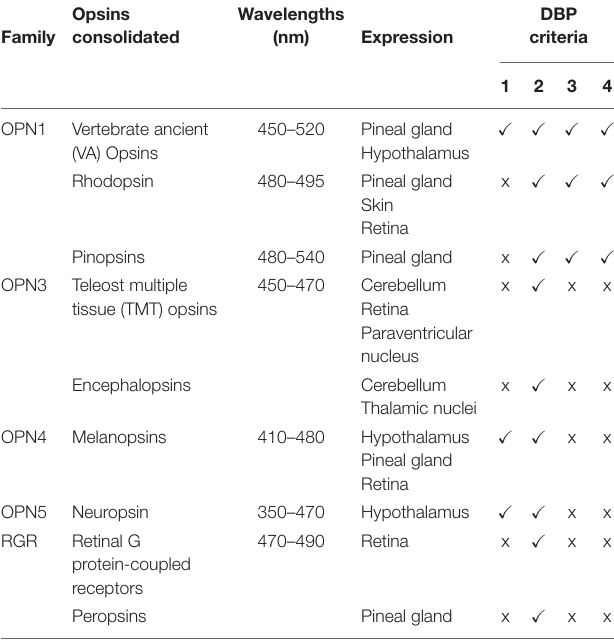
TABLE 1 | Summary of the candidates for deep brain